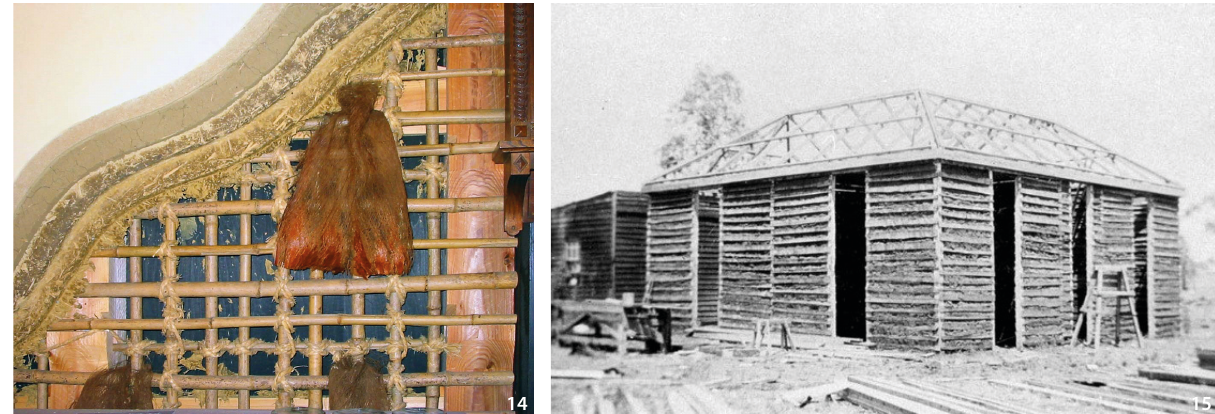
Figure 14 Cane and daub wall, Uchiko, Japan, interpretative display showing the layers of mud plastering (Source: Miles Lewis). Figure 15 ‘Rocky View’, Alectown, New South Wales, under construction, 1914 (Source: State Library of New South Wales, Sydney, 00058).